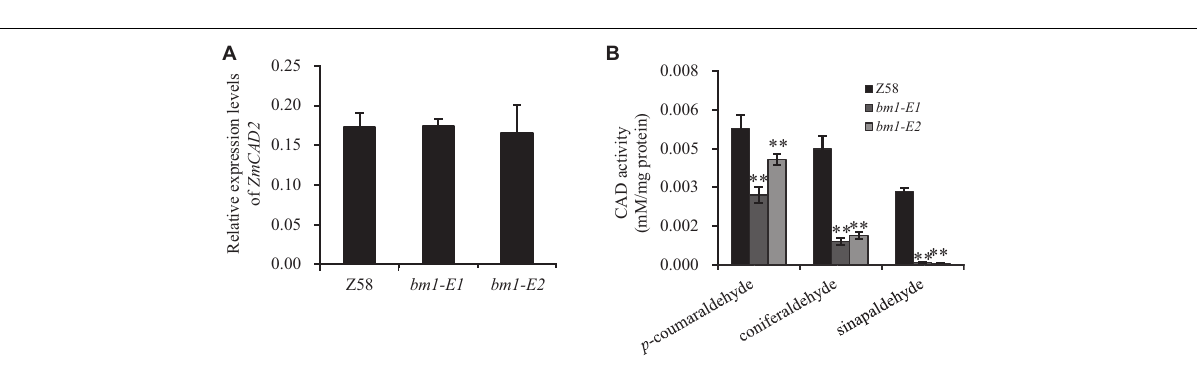
FIGURE 3 | Effects of ZmCAD2 mutation in gene expression and CAD enzymatic activity in midribs of the fourth leaf collected from 60-days old plants. (A) Gene expression levels of ZmCAD2 . (B) CAD enzymatic activity in different substrates: p -coumaraldehyde, coniferaldehyde, and sinapaldehyde. Values shown are means ± SD from three technical replicates and three biological replicates. Two asterisks indicate significance corresponding to P < 0.01 (Student’s t